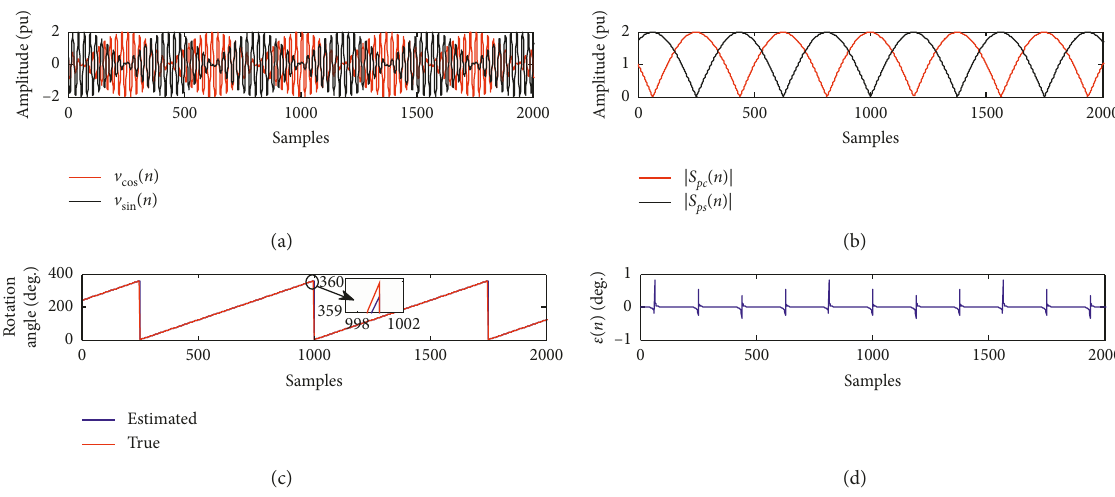
Figure 7: Estimation error of